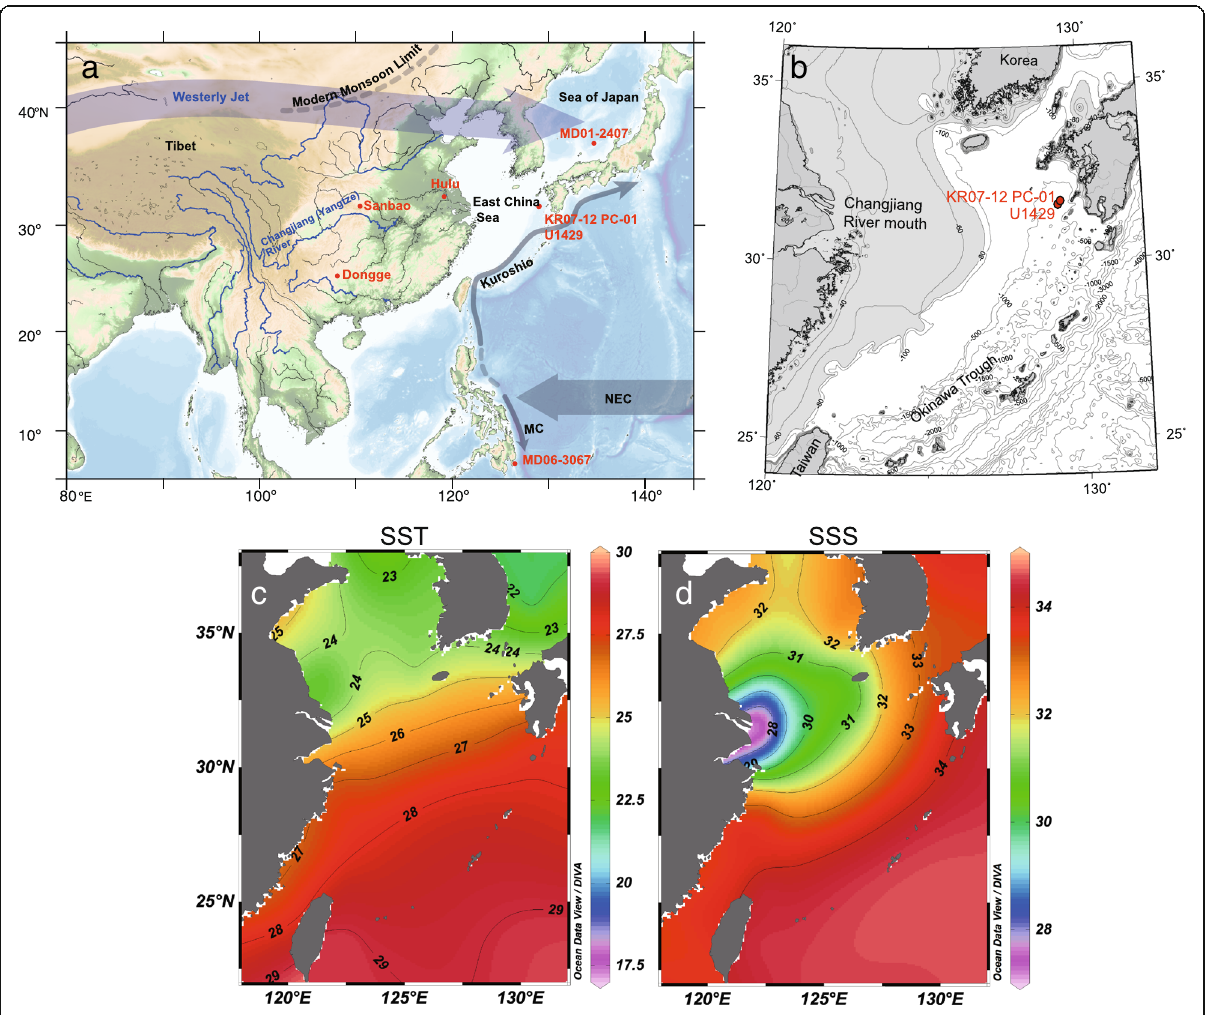
Fig. 1 a Locality map showing site of KR07-12 PC-01 and reference sites. b Site location in the ECS during MIS 3 and the shore area (shaded area) at − 80 m sea level during MIS 3. c SST (Locarnini et al. 2010) and d SSS in July (Antonov et al. 2010) in the